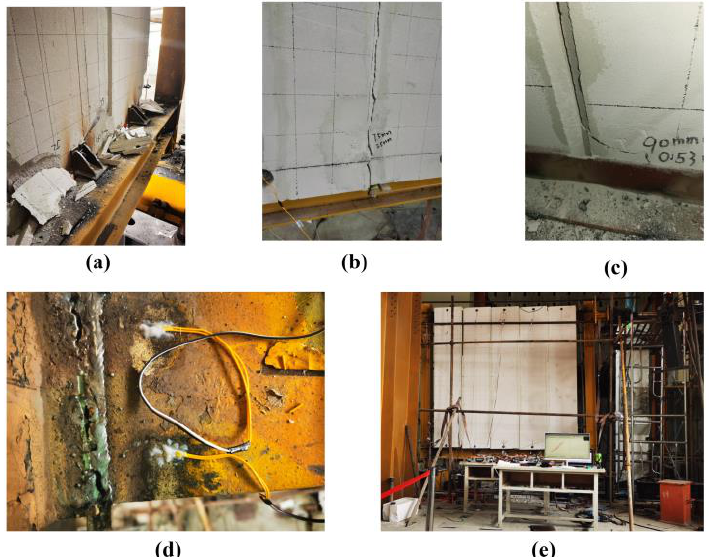
Figure 13. Images depicting the results of the loading test used for specimen SF-2: ( a ) fragments of the AAC wallboard fall off; ( b ) splicing of the AAC wall panel due to mortar cracking; ( c ) damaged corners of the AAC wall panel; ( d ) weld fracture of the steel frame; ( e ) overall view of the wall panel frame after the test.